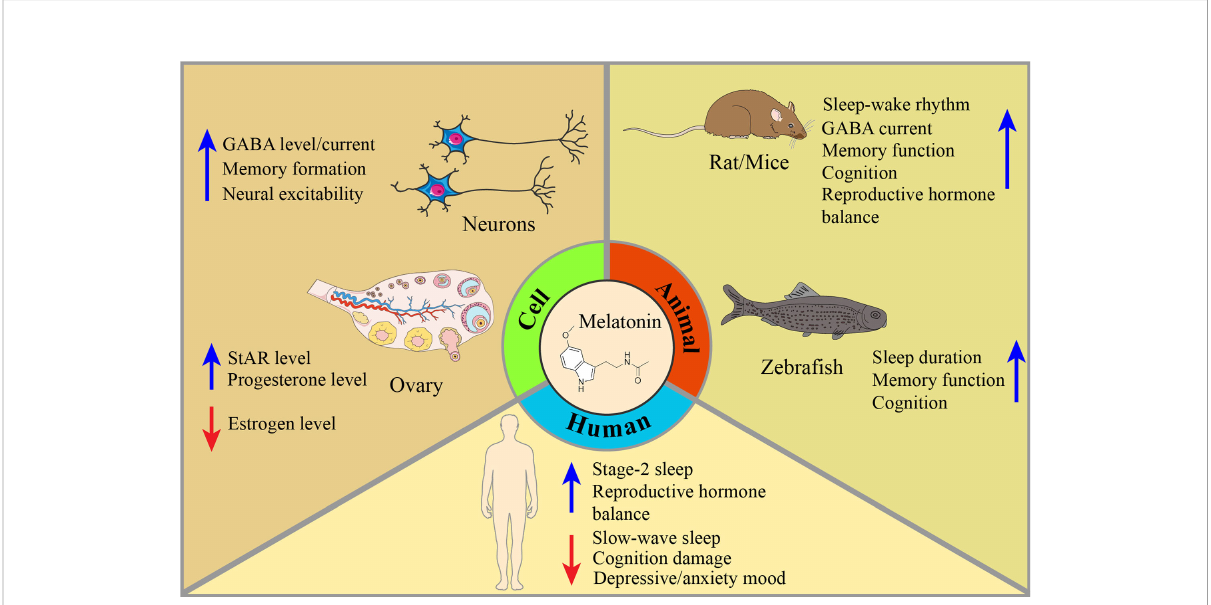
FIGURE 1 Mechanisms of melatonin restoration in PMS/PMDD-related symptoms, given cells, animals, and humans. Melatonin is involved in many aspects of PMS/PMDD. In cells, melatonin can upregulate GABA levels and its current among neurons, promote memory formation, and increase neuron excitability. To adjust the imbalance of the ovary ’ s hormones, melatonin can increase the levels of StAR and progesterone, and decrease the level of estrogen. In animals, dysfunction of sleep-wake rhythm, GABA current, memory function, cognition, and reproduction hormone balance have been modulated by melatonin intake. Meanwhile, melatonin ’ s improvement of sleep, memory, and cognition is also discovered in the zebra fi sh model. In humans, the effect of melatonin has long been applied in improving sleep quality. In PMS/PMDD-related symptoms, melatonin can restore stage-2 sleep and reproductive hormone balance and reduce slow-wake sleep, cognitive damage, and depressive/anxiety mood derived from